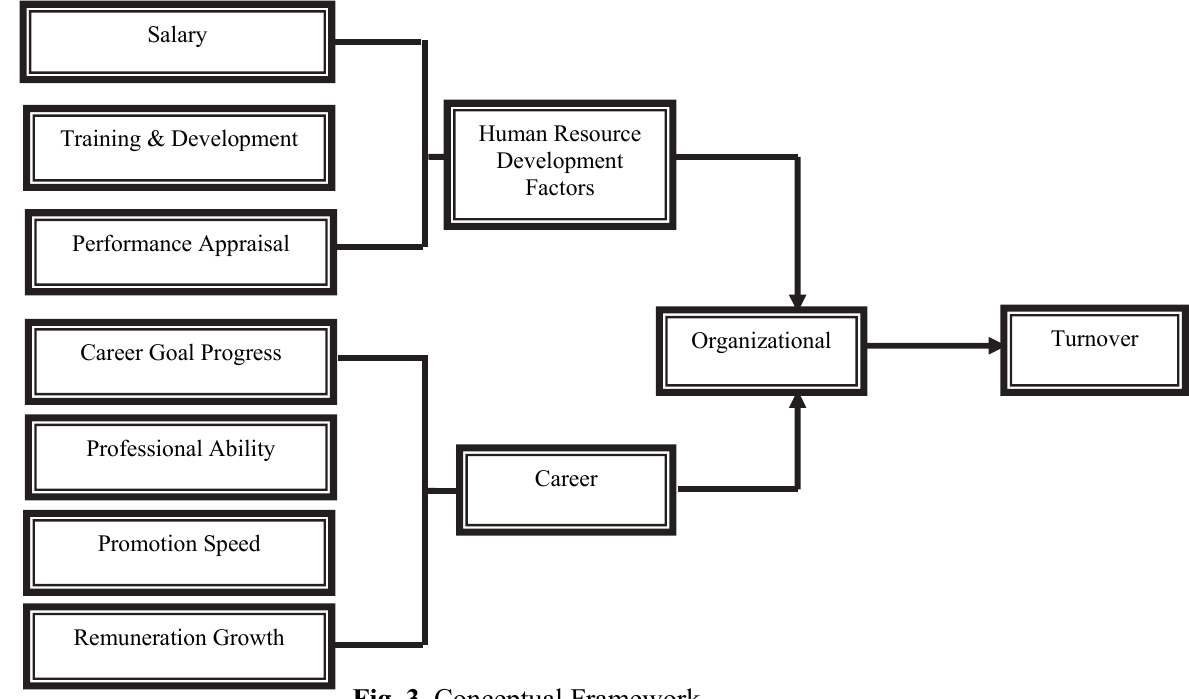
Fig. 3. Conceptual